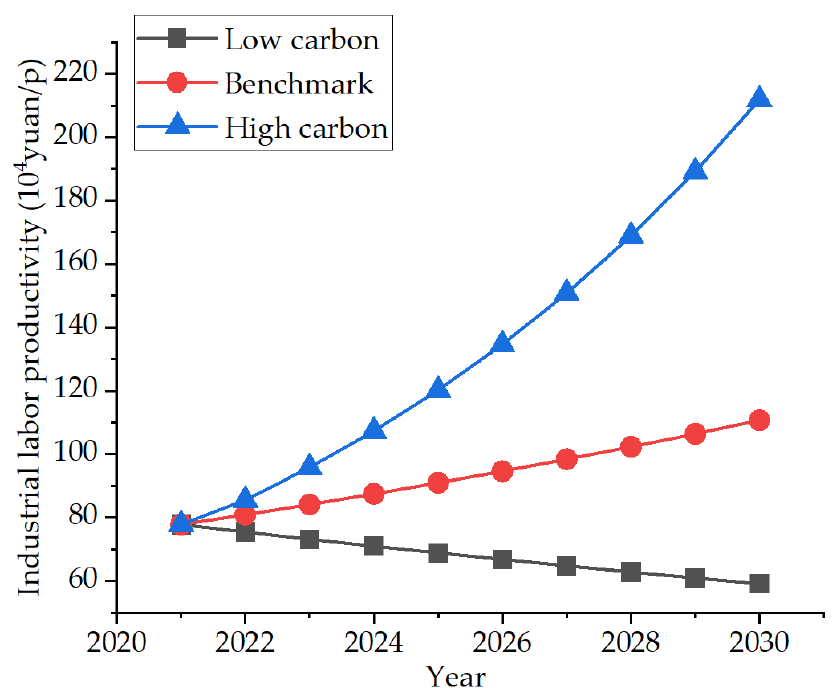
Figure 7. Three industrial labor productivity development scenarios.